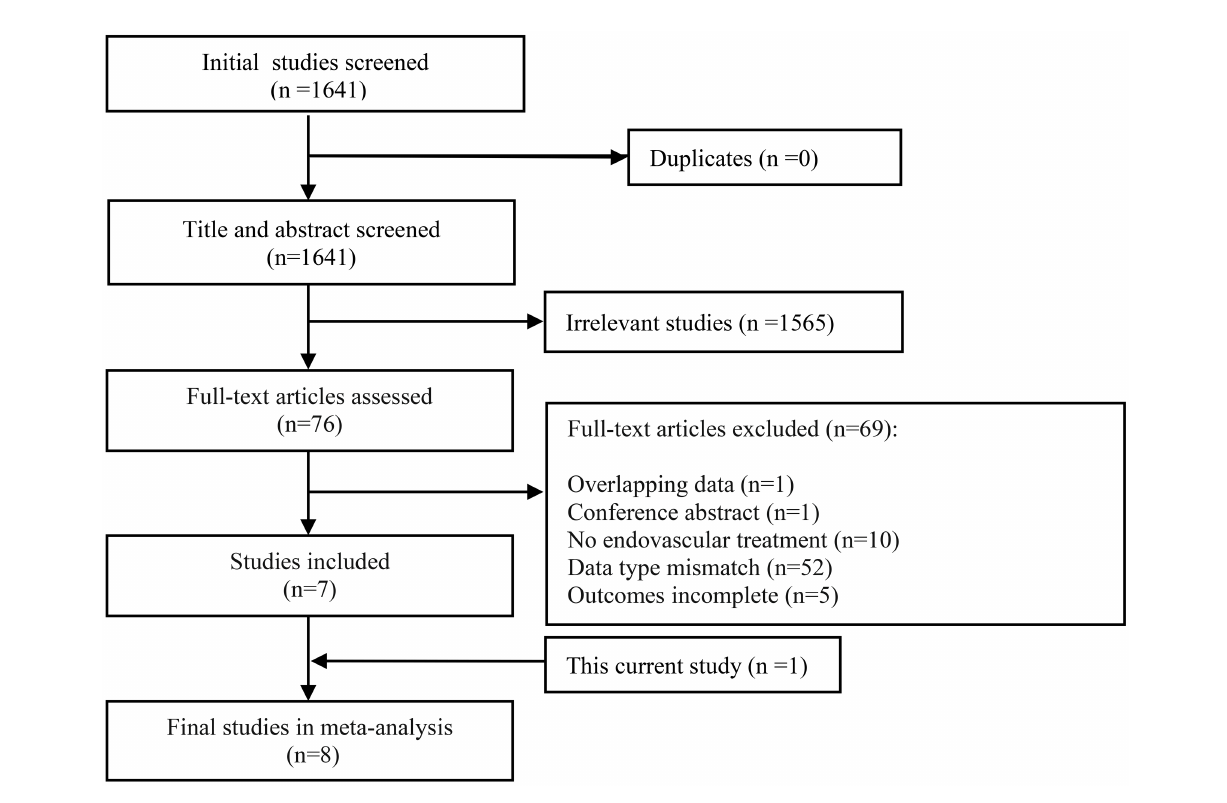
FIGURE 1 Flow diagram of literature selection for